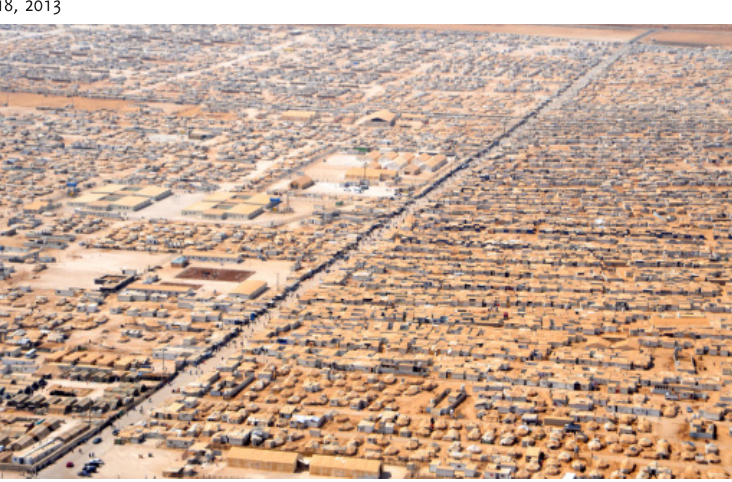
The population of the camp reached its maximum in April 2013 at 202,993 people. It currently hosts 79,900 persons (Available from: http://data.unhcr.org/syrianrefugees/settlement.php?id=176&region=77&coun- try=107, updated 2016 Sep 18, cited 2016 Sep